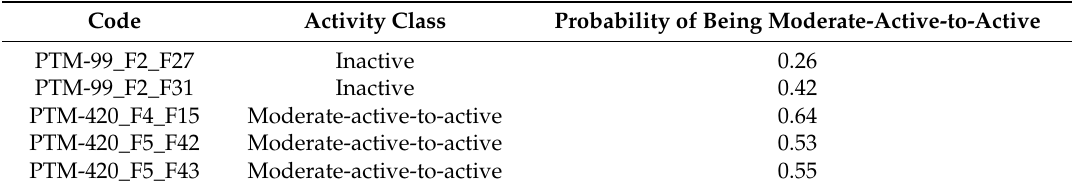
Table 9. Prediction of activity classes against HCT116 of the five pure compounds with the best model.